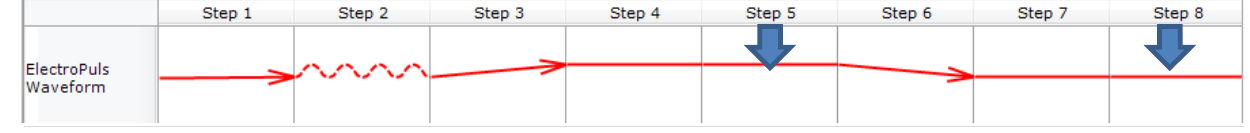
Figure 2: Illustration of the test procedure followed during the digital image correlation procedure.